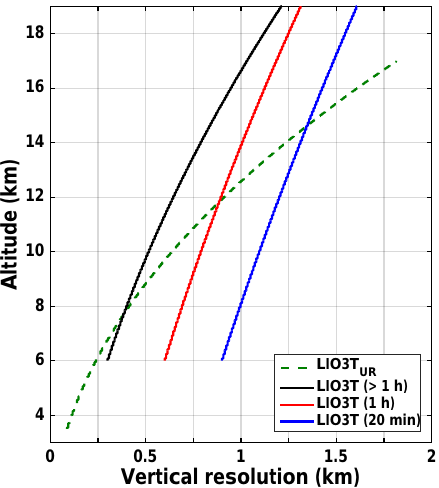
Figure 3. Mean vertical resolution of LIO3T UR profiles (dashed green curve) and LIO3T profiles for integration times greater than 1h (black curve), equal to 1h (red curve) and 20min (blue